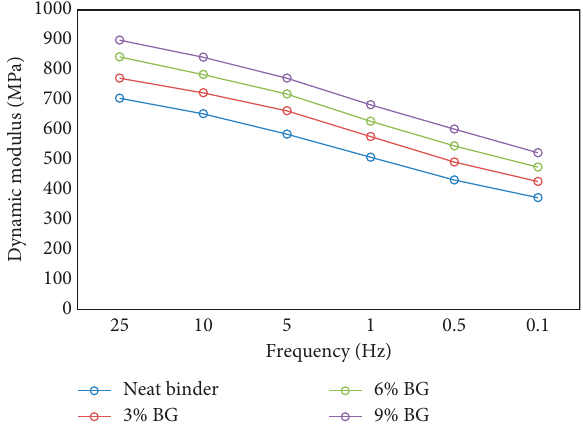
Figure 15: Dynamic modulus graph at 55 ° C.